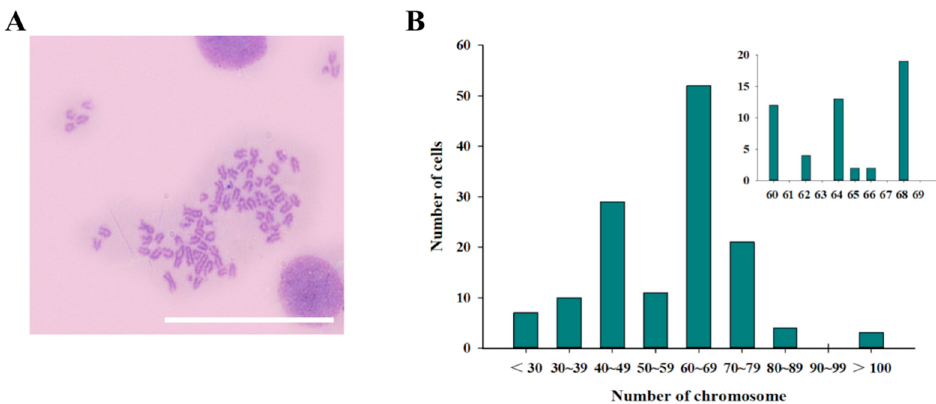
Figure 4. Chromosome morphology and frequency distribution of the number of entries in JFSP cells. ( A ) Chromosome morphology and ( B ) chromosome number statistics of JFSP cells treated with